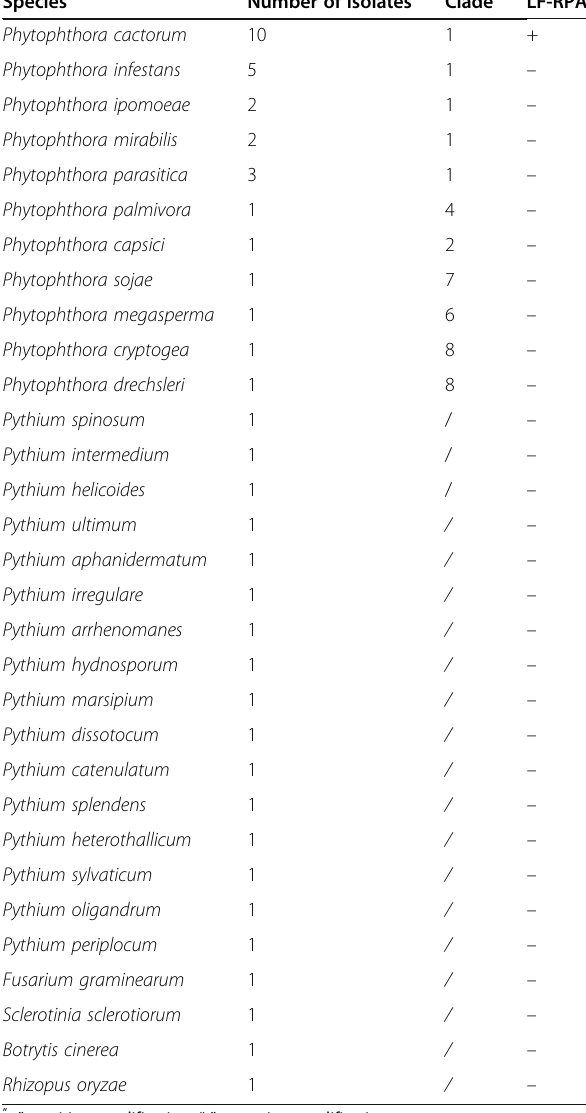
Table 1 Isolates used for specificity test of the LF-RPA assay